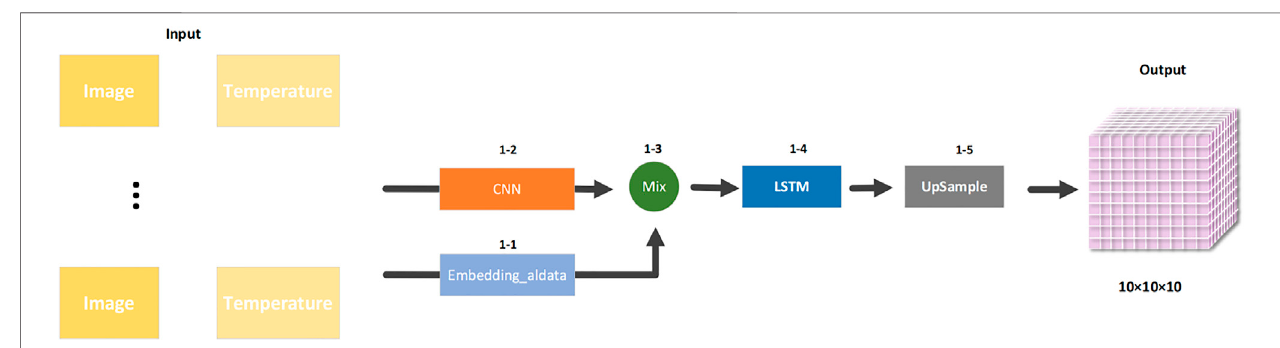
FIGURE 5 | Overall design of deep learning